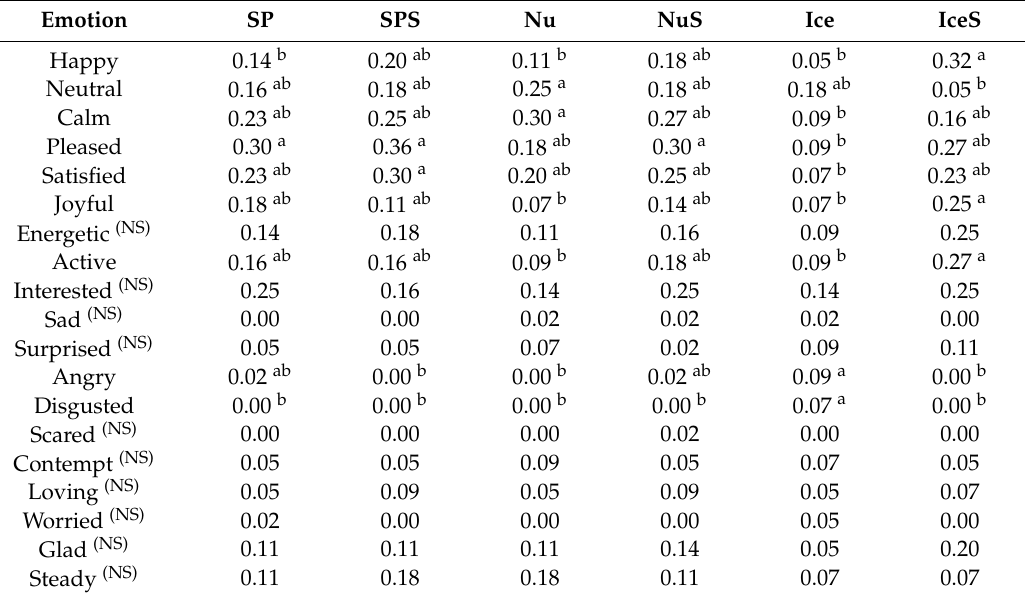
Table 6. Frequency of selection of the emotion-terms from the check all that apply sensory response for visual assessment. Di ff erent letters denote significant di ff erences between samples assessed using Cochran Q and pairwise comparison tests